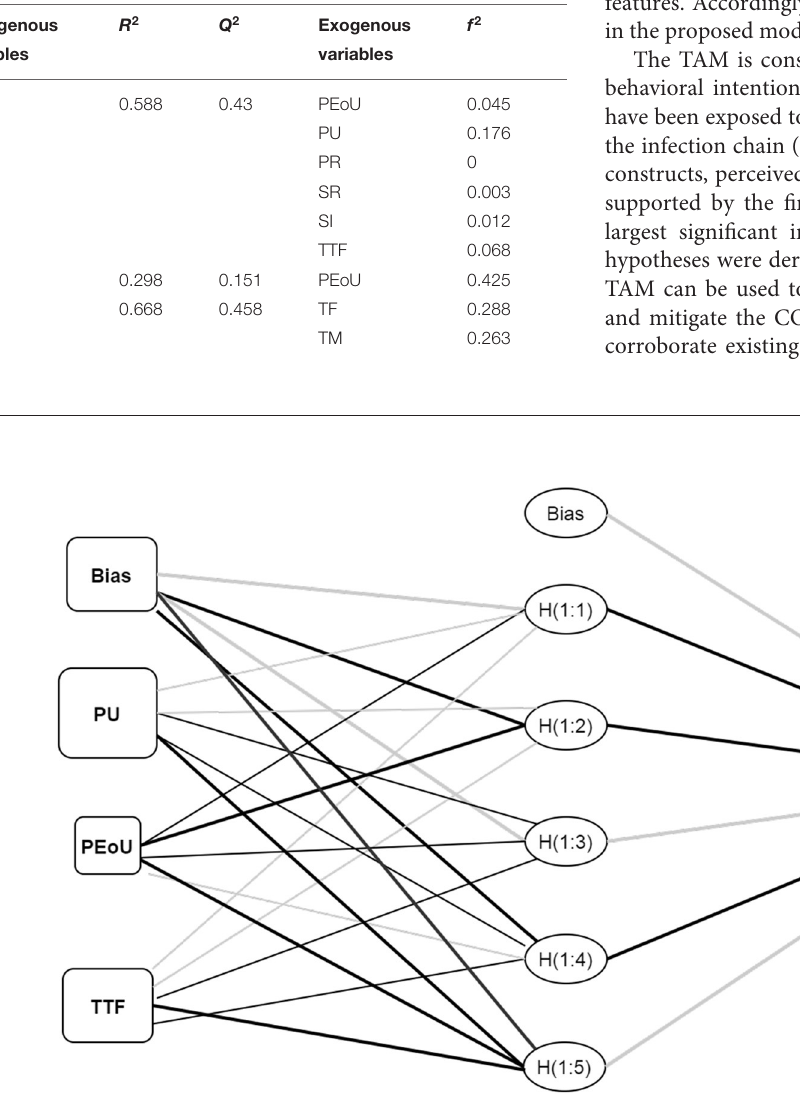
FIGURE 4 | Artificial neural network (ANN) model. Hidden layer activation function: hyperbolic tangent; output layer activation function: sigmoid; input neurons: PU, perceived usefulness; PEoU, perceived ease of use; TTF, task-technology fit.